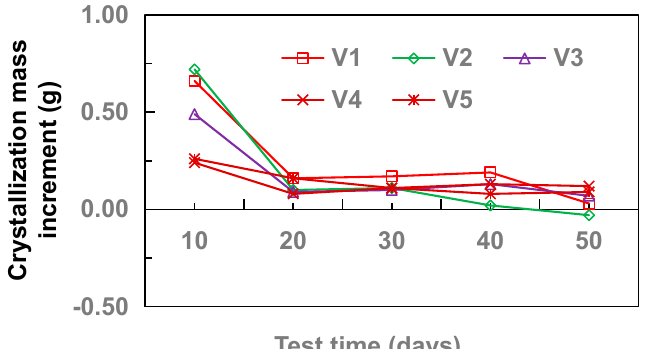
Figure 8. Variation of crystal mass increment with